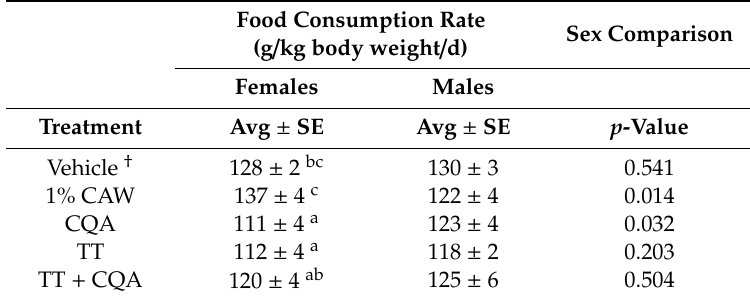
Table 2. Analysis of dosing in all treatment